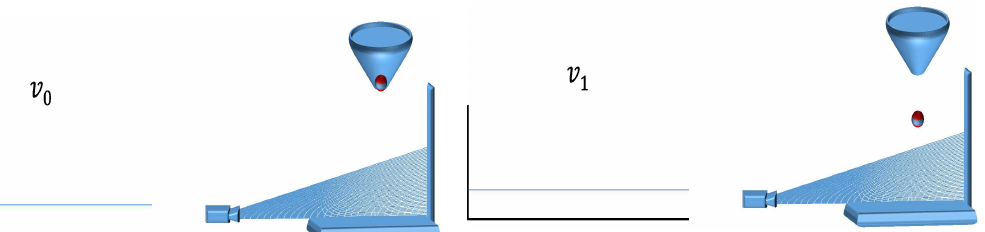
Time t 1 . The marble falling, not yet passing through the beams. All beams hit the white sticker.